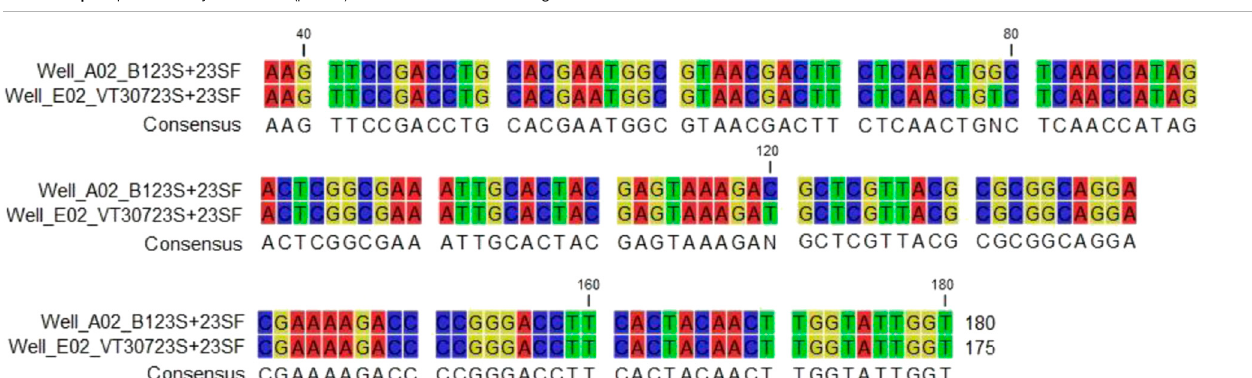
TABLE 2 | Sequence analysis of Cla S (parent) and Cla R mutant M. smegmatis